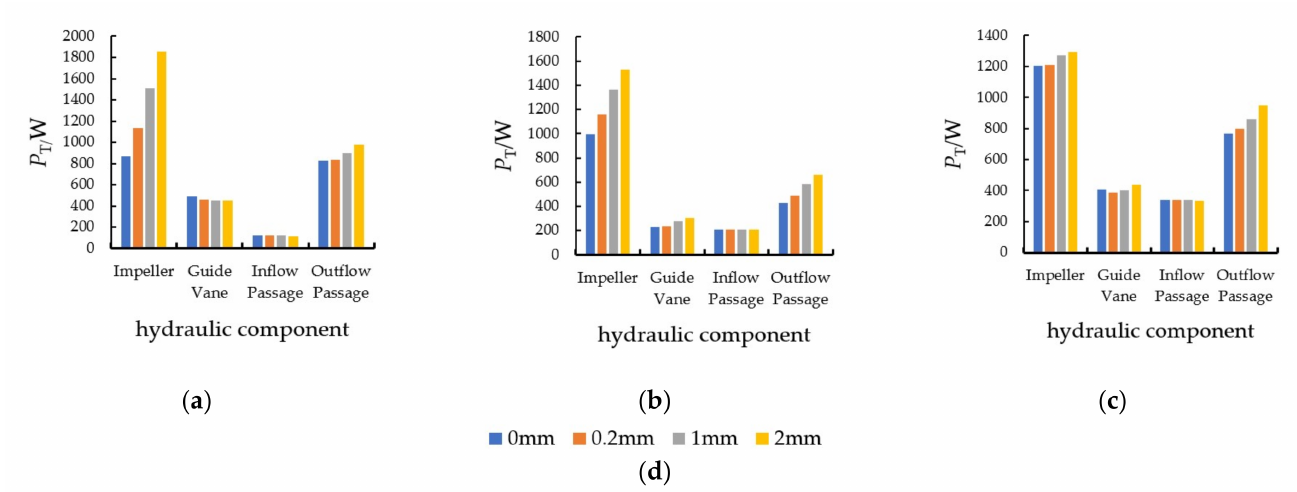
Figure 9. Influence of tip clearance on total dissipation under pump condition; ( a ) 0.8 Q des ; ( b ) 1.0 Q des ; ( c )1.2 Q des ; ( d ) Legend.